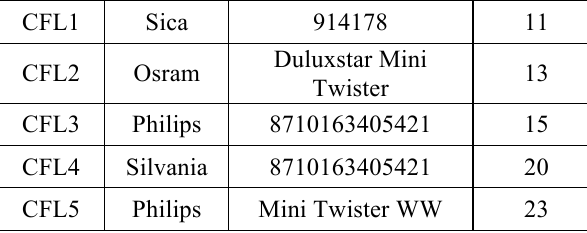
Table 1: Technical data for tested lamps.